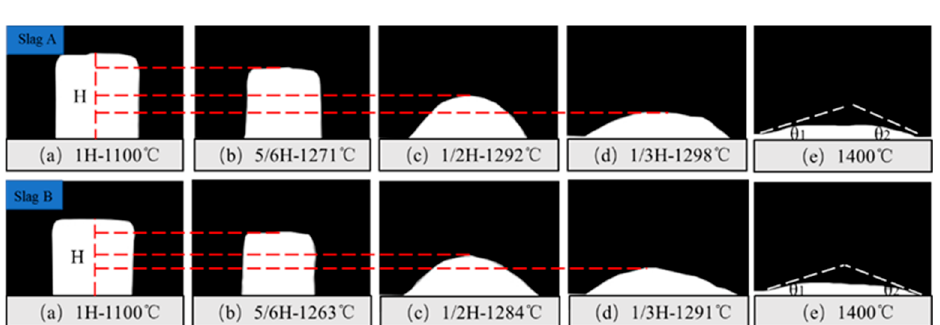
Figure 2. Schematic profiles of slag at different temperatures.